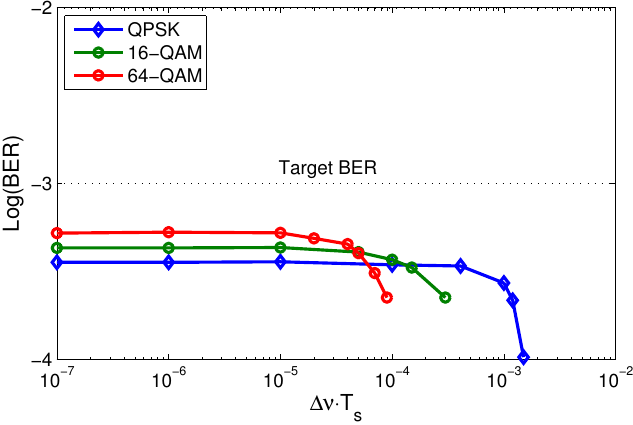
Figure 2. Estimated BER from error vector magnitude (EVM) analysis for different modulation formats at the target BER of 10 − 3